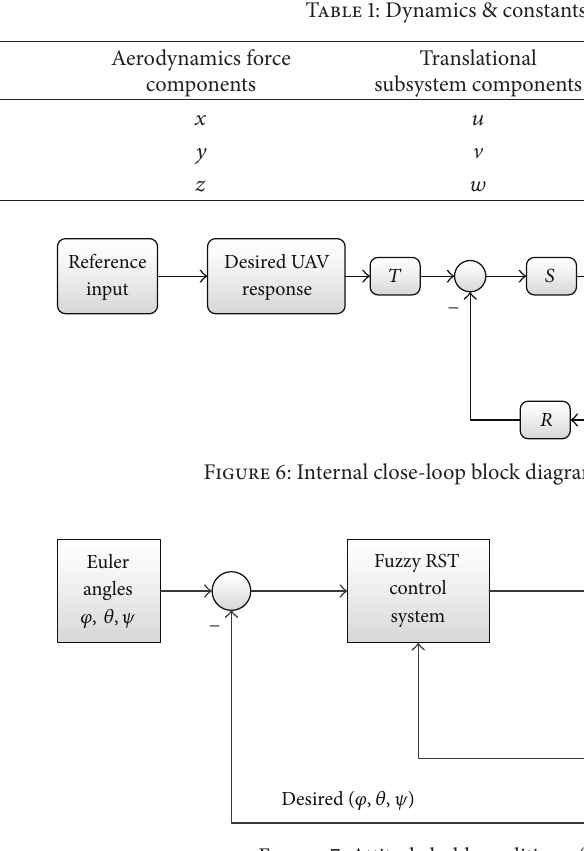
Figure 7: Attitude hold condition of trirotor